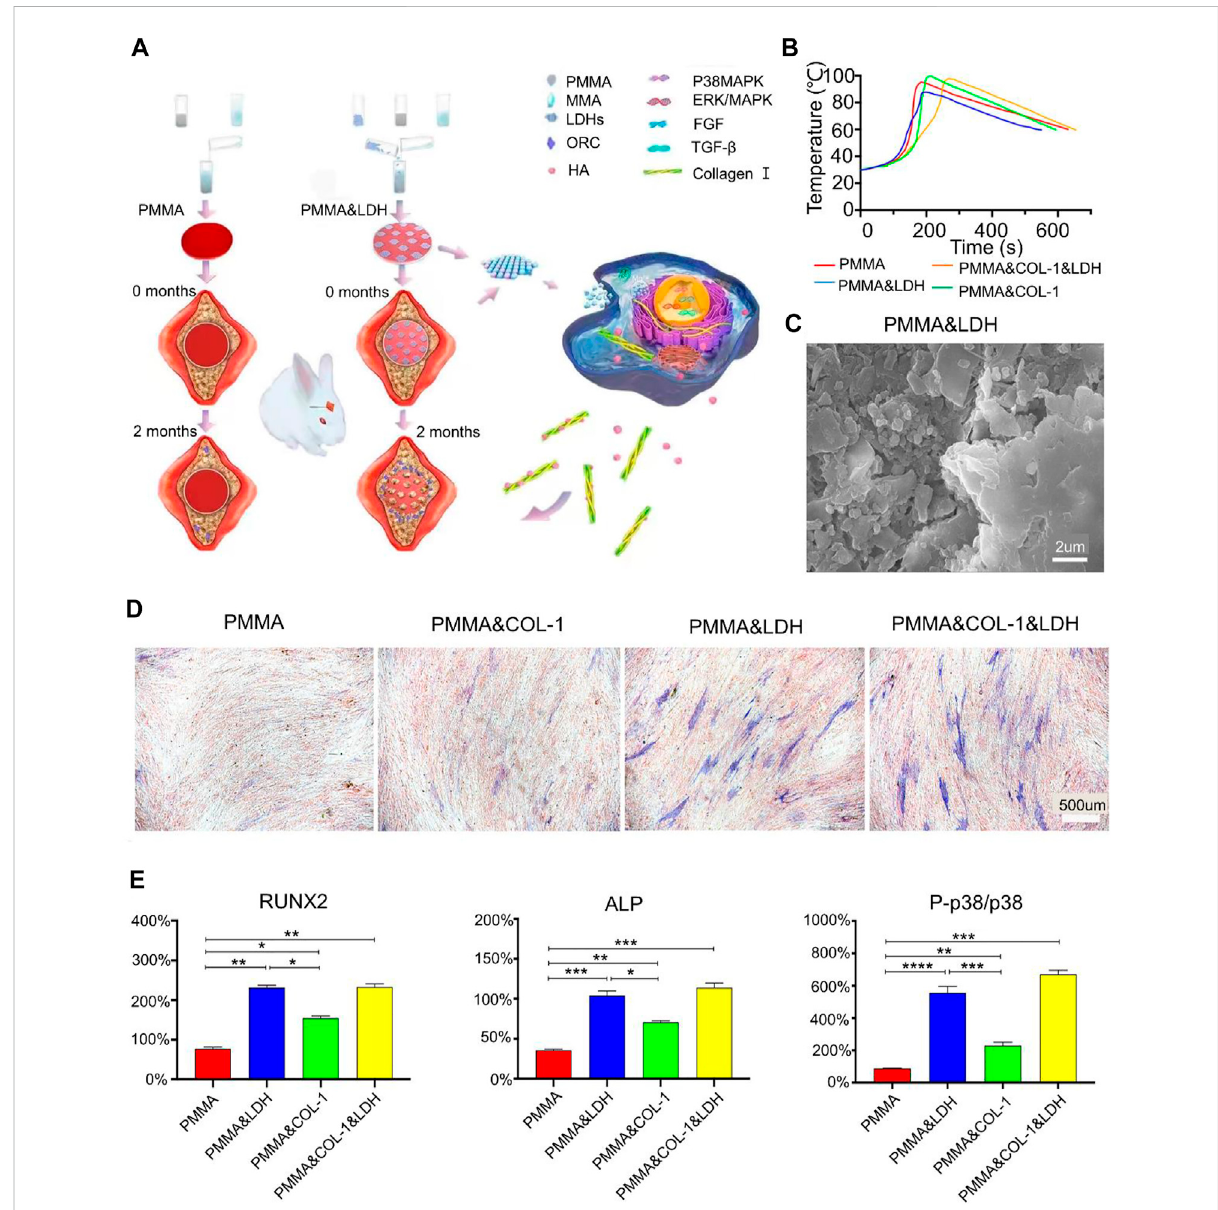
FIGURE 1 (A) Schematic illustration of layered double hydroxide-modi fi ed bone cement for promoting bone repair. (B) Temperature change during the reactionoftheBpolymer. (C) ScanningelectronmicroscopeimageofPMMAandLDH. (D) Osteogenicdifferentiationabilitywasassessedbyalkaline phosphatase (ALP) staining assay on day 14 of in vitro cell experiments (blue stained area represents alkaline phosphatase). (E) In vivo assay to assess osteogenic differentiation. Relative gene transcript levels of osteogenic markers (i.e., runt-related transcription factor 2 (Runx2), ALP, p38, and P-p38) in human bone marrow-derived mesenchymal stem cells on day 7. An increased ratio of P-p38 to p38 indicates the activation of the p38 MAPK signaling pathway. Reproduced with permission from (Wang et al.,